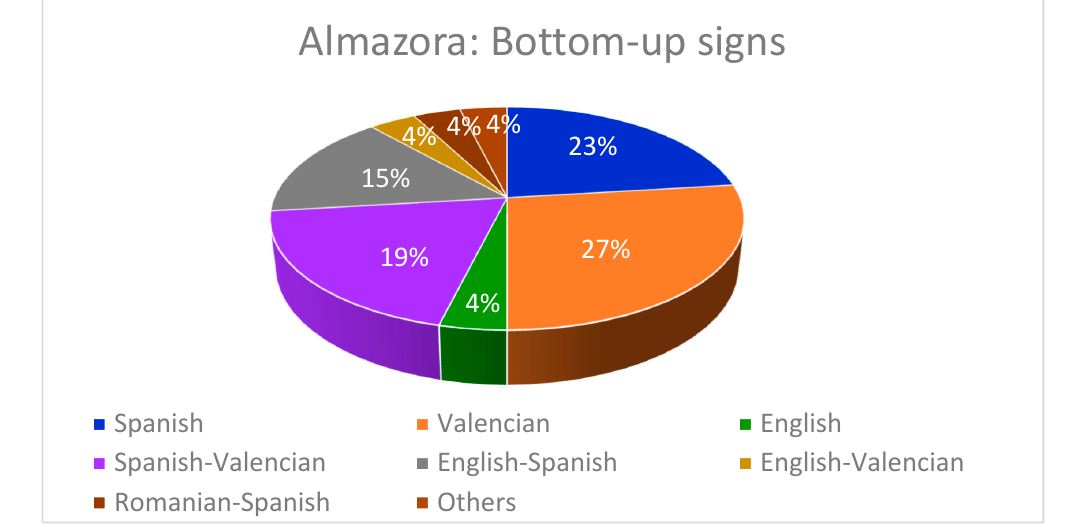
Figure 29. Almazora: Bottom-up signs.